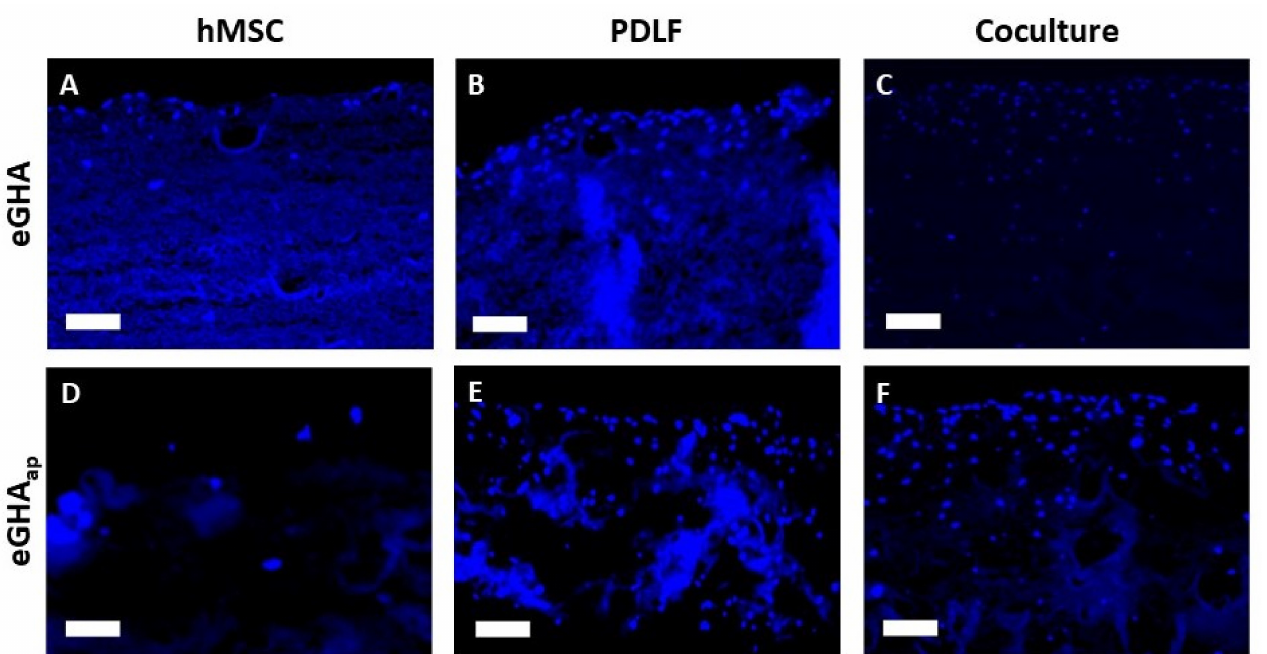
Figure 3. Representative cutouts of 4 (cid:48) ,6-diamidin-2-phenylindol e (DAPI) stained sections from eGHA and eGHA ap nonwovens populated with hMSCs, PDLFs, or cocultures after an incubation period of 21 d. The upsides of the monoculture scaffolds are oriented towards the top of the picture. For the cocultures ( C , F ), the margins of the PDLF-populated downsides are shown. ( A ) hMSCs, ( B ) PDLFs, or ( C ) cocultures were grown on eGHA scaffolds. Cell nuclei are presented as blue dots, while parts of the nonwovens also show some background fluorescence. Accordingly, eGHA ap samples populated with ( D ) hMSCs, ( E ) PDLFs, or ( F ) cocultures are presented, showing a tendency towards increased cell densities when compared to eGHA nonwovens. Scale bars represent 100 µ